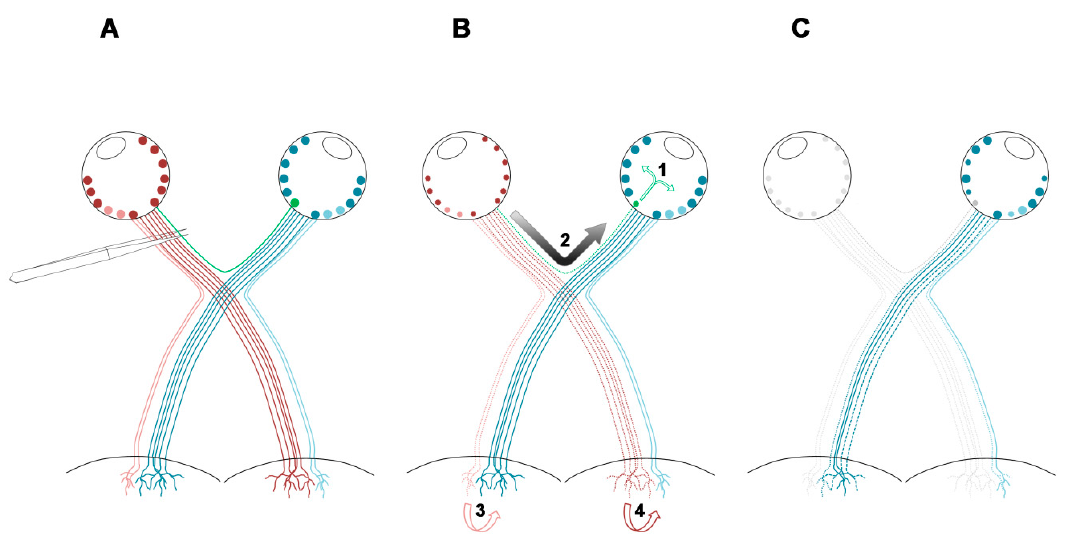
Figure 8. Mechanisms implicated in the contralateral response.( A ) In rodents, ~96%–99% of the RGCs project to the contralateral superior colliculi (dark red, dark blue lines [51,52]). The ipsilateral projection (light red, light blue lines) amounts for 1.5% to 4% of the total RGCs. This uncrossed projection is significantly smaller in albino animals [29,39–43]. Finally, very few RGCs project to the other retina (green line, [46–50]). Upon optic nerve axotomy, the parent RGCs will die by the direct injury (( B ) dotted lines, smaller RGC somas; ( C ) grey somas and axons). The massive loss of RGCs and the degeneration of their axons will cause a cascade of events ending in the death of RGCs in the un-injured retina. ( B1 ) Stress / danger signals from the retino-retinal RGCs a ff ected by the axotomy. ( B2 ) Propagation of the glial reaction through the optic chiasm. This response would a ff ect the optic nerve axons of the contralateral retina (( C ) dashed blue lines), and eventually would reach the un-injured retina, impacting on the intraretinal axons and / or the RGC somas. ( B3 ) Reaction to the loss of the injured ipsilateral projection that damages the contralateral projection of the un-injured retina. ( B4 ) Reaction to the loss of the contralateral projection that harms the ipsilateral projection of the un-injured retina [14]. The dea ff erentation of the superior colliculi would cause the retrograde death of the parent RGCs (( C ) dotted blue lines). These mechanisms alone or in combination, together with a possible systemic response, would finally cause the death of RGCs in the un-injured retina (( C ) smaller blue somas). Because the loss of RGCs in the contralateral retina was observed earlier when the lesion